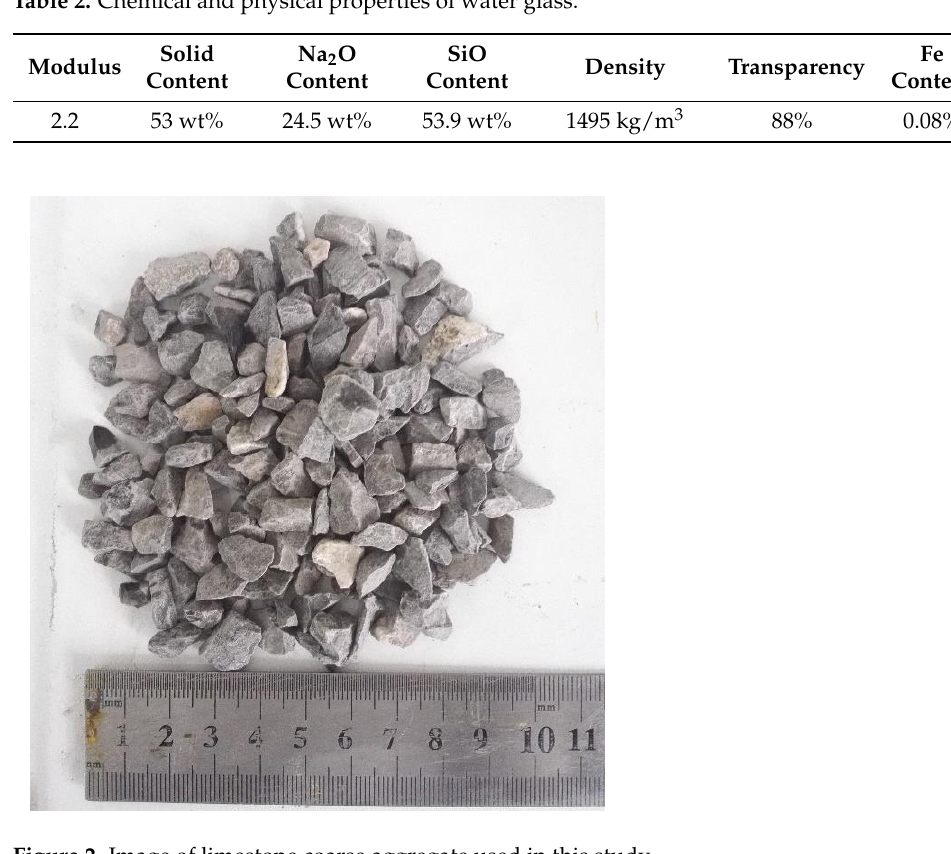
Figure 2. Image of limestone coarse aggregate used in this study. Table 3. Properties of coarse aggregate.